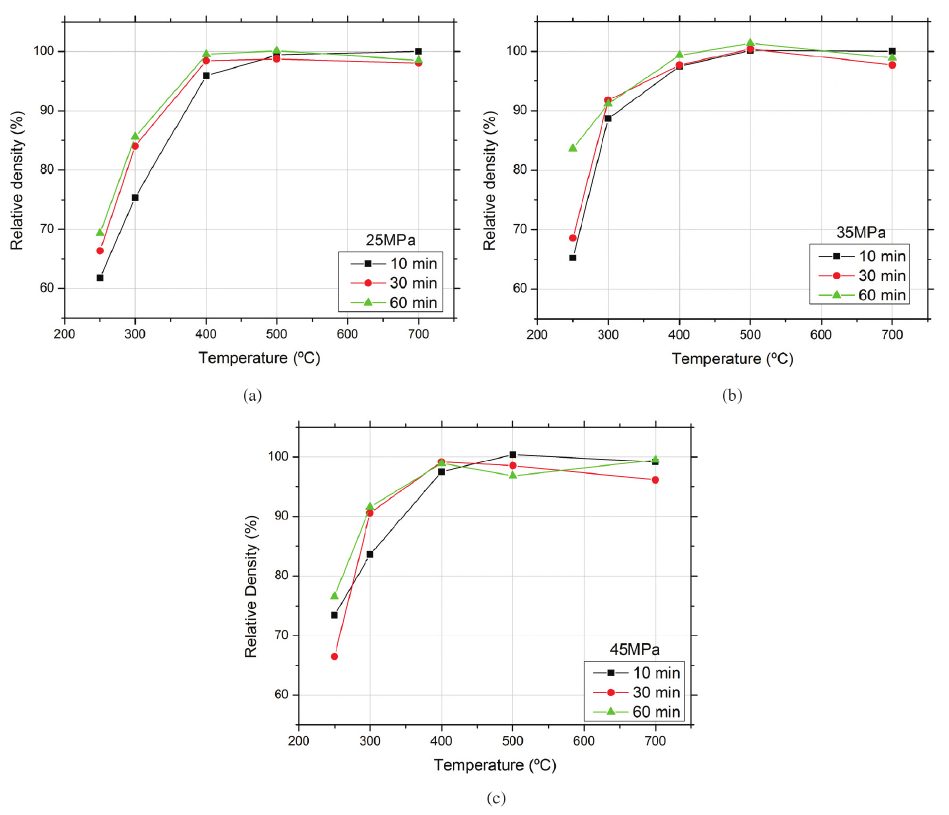
Figure 7. Influence of the processing parameters (pressure, time and temperature) on the relative density of the hot pressed sterling silver powder